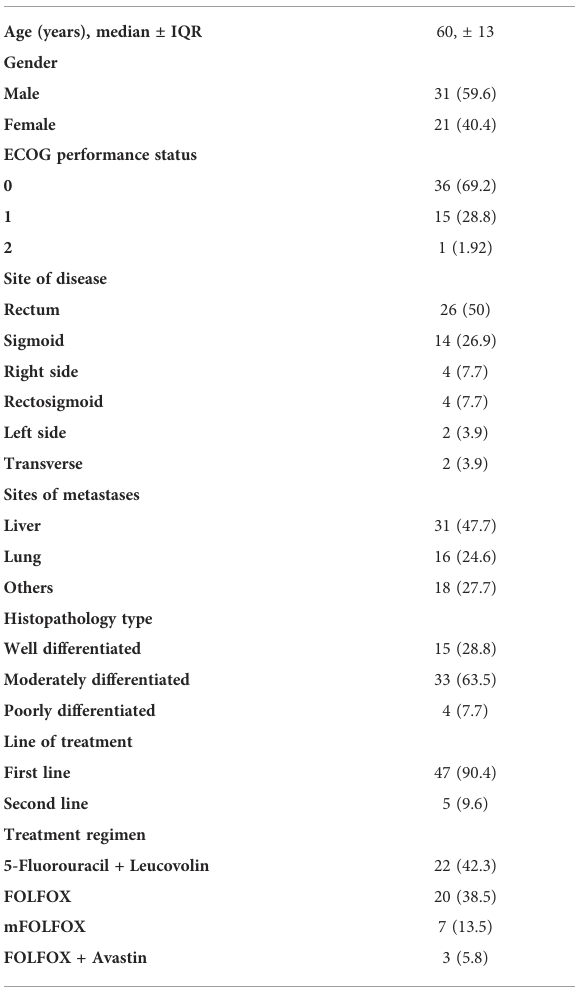
TABLE 2 Patient characteristics.